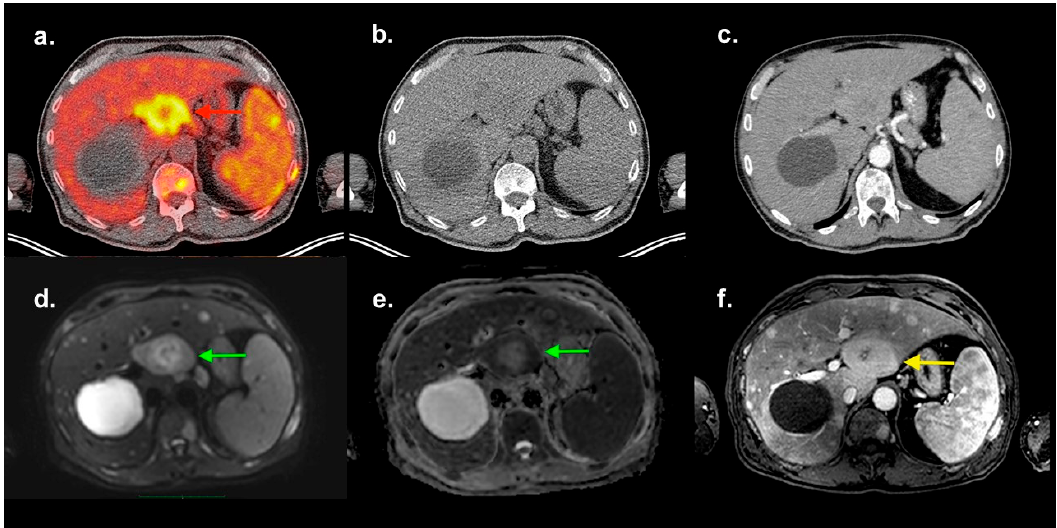
Figure 1. Newly diagnosed patient with multiple myeloma (MM, Typ IgA Kappa, Stage IIIA